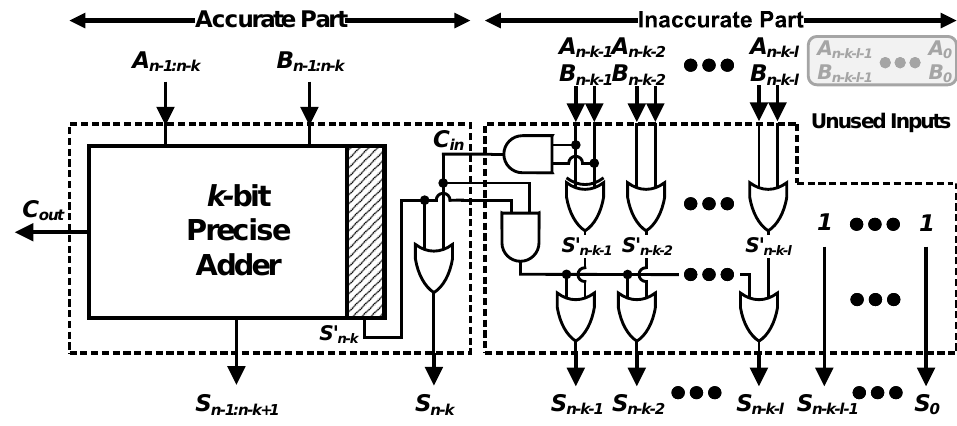
Figure 1. Overall architecture of the proposed adder, carry OR error reduced adder